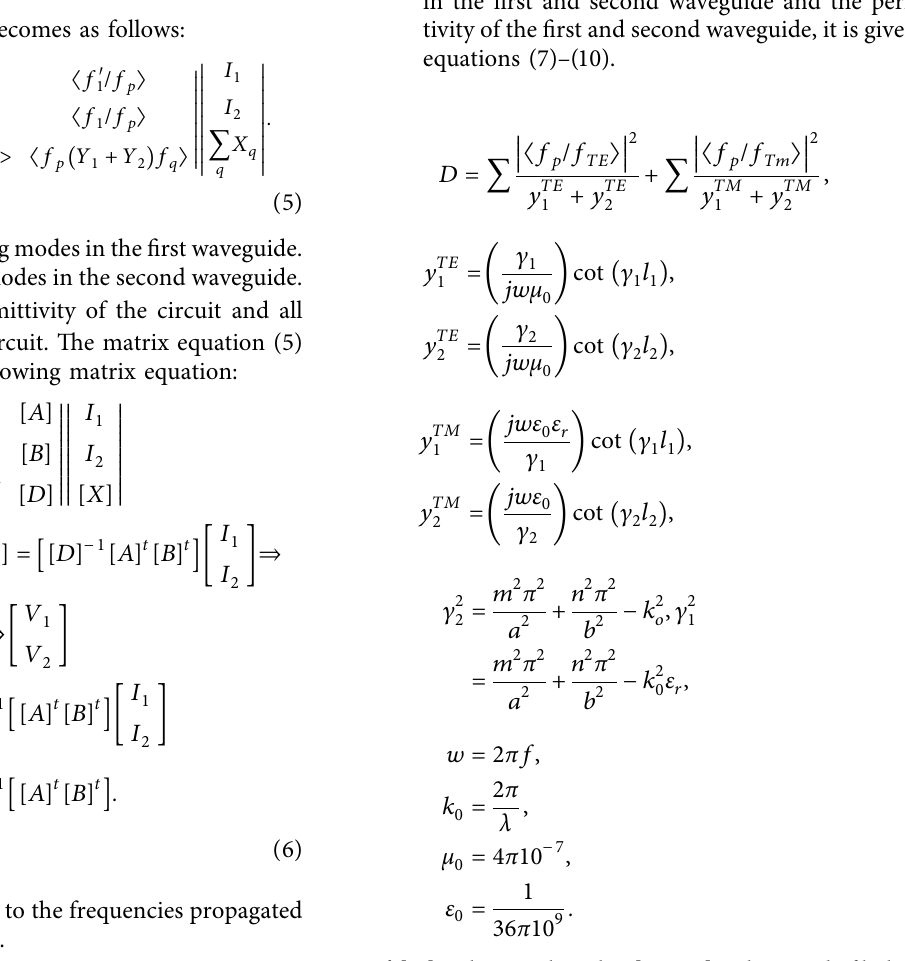
Figure 1: Discontinuity in the waveguide (a) and equivalent circuit (b). a, b: the dimensions of the first waveguide (the substrate of the antenna). c, d: the dimensions of the second waveguide (patch antenna). Y 1 , Y 2 : the equivalent permittivity expressing the first and second waveguide. J 1 : the current resulting from the propagating modes in the first waveguide. J 2 : the current resulting from the propagating modes in the second waveguide. E 1 : the voltage source resulting from the propagating modes in the first waveguide. E 2 : The voltage source resulting from the propagating modes in the second waveguide. E : the voltage source expressing the discontinuity in the discontinuity impedance. f q is the propagating modes in the discontinuity region.